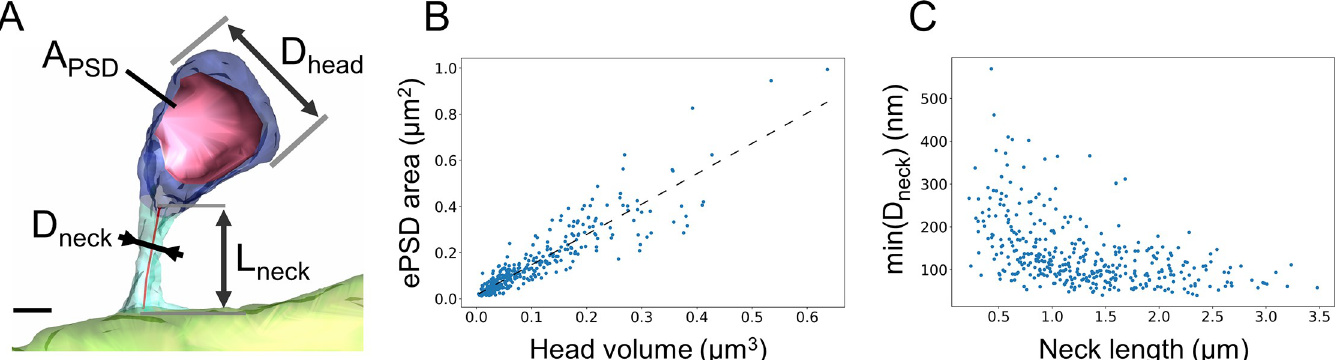
Fig 2. Spine morphometry along basal dendrites of L2/3 cortical PNs. (A) 3D reconstruction of a dendritic spine from an SBEM stack. Dendritic shaft is in light green, spine neck in turquoise, spine head in blue, and PSD surface in red. The following parameters were measured: PSD area, head diameter, neck diameter, and neck length. Scale bar: 300 nm. (B) Linear correlation of PSD area and spine head volume. R 2 = 0.82. (C) Plot of the minimal spine neck diameter as a function of spine neck length. Spearman correlation coefficient is − 0.58. N = 390. The data underlying this figure can be found in https://www.opendata.bio.ens.psl.eu/3DCLEM-Spines/data/Data_ related_to_Fig 2.xlsx (login: guest; password: EnsData0811). ePSD, excitatory postsynaptic density; L2/3, layer 2/3; PN, pyramidal neuron; PSD, postsynaptic density; SBEM, serial block–face scanning EM.